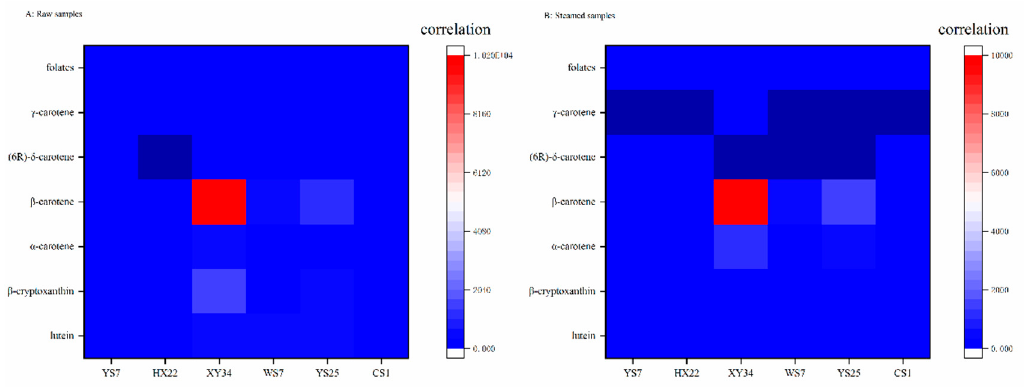
Figure 3. Correlation heatmap of carotenoids and folates in SPRs. Table 2. Pearson correlation coefficient of carotenoids and folate content with thermal processing.